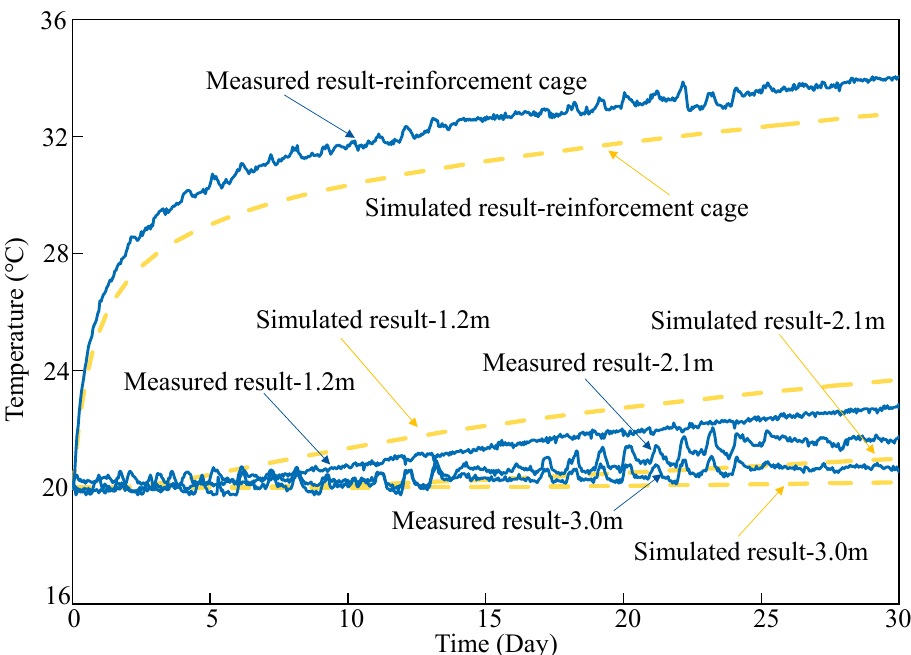
Figure 4. Comparison between simulated and measured results at different locations.